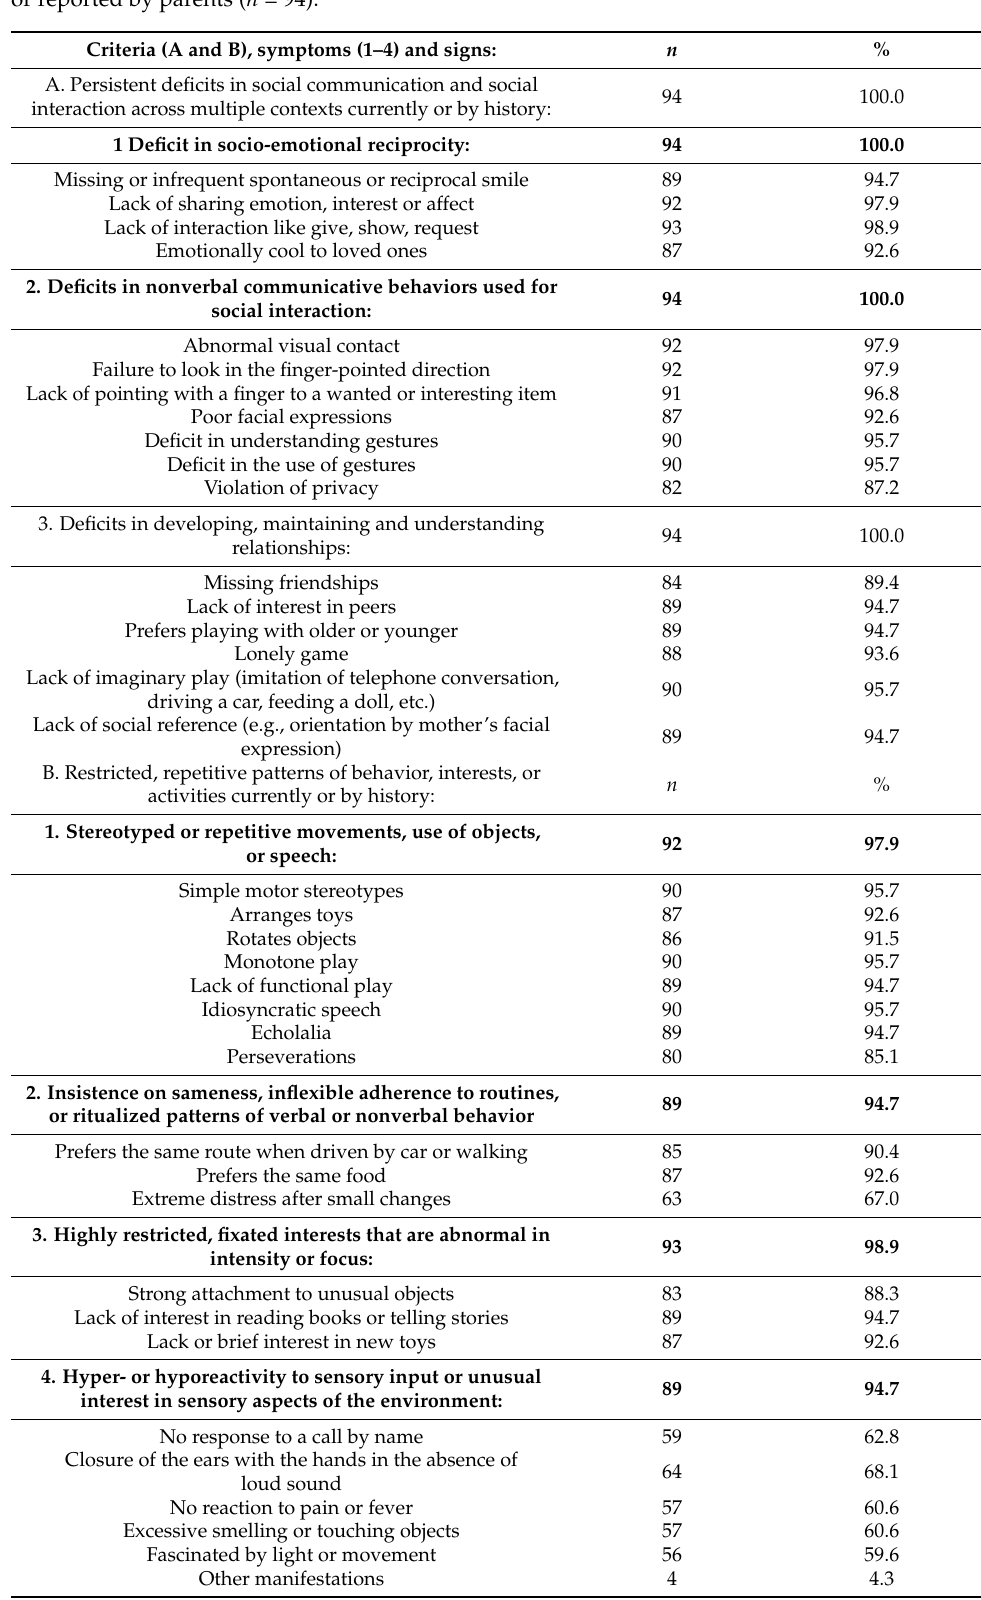
Table 3. DSM-5 symptoms of ASD and relevant clinical signs observed during the clinical examination or reported by parents ( n =